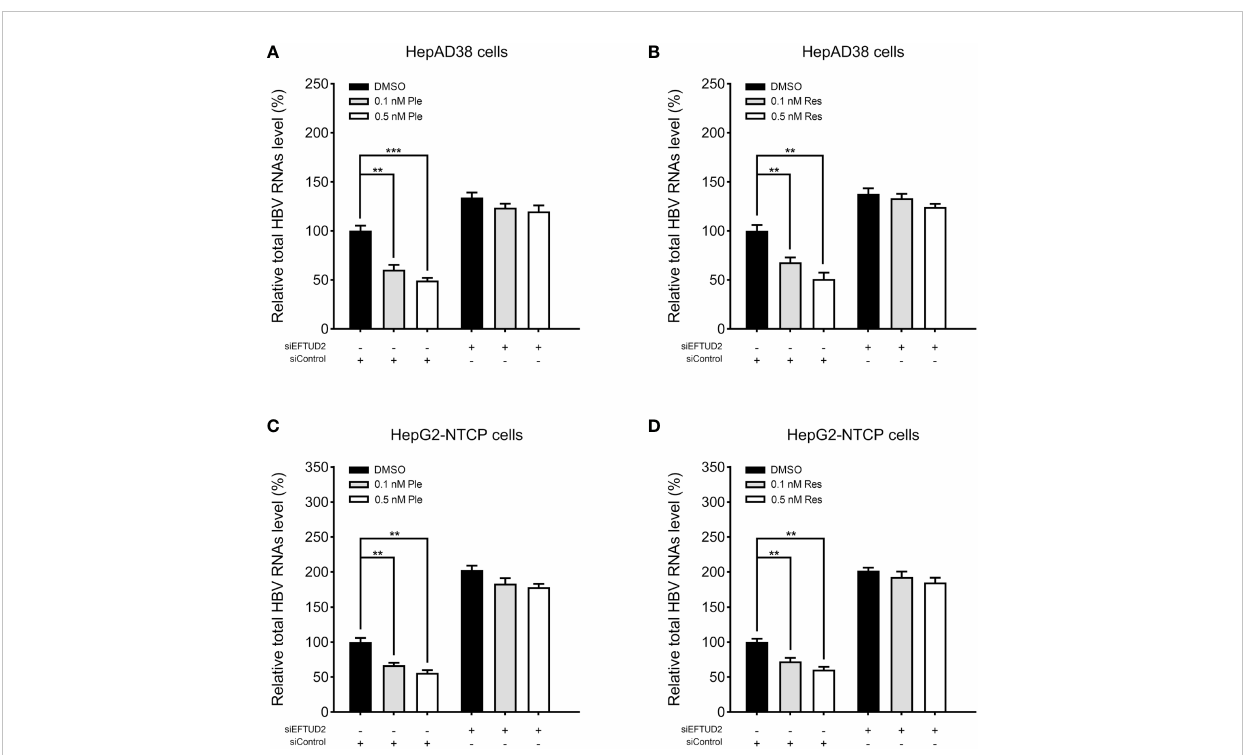
FIGURE 8 Plerixafor and resatorvid inhibited HBV by targeting EFTUD2. HepAD38 and HepG2-NTCP cells were transfected with siRNAs targeted EFTUD2 (siEFTUD2) or negative control (siControl) , and then, treated with DMSO, plerixafor or resatorvid at indicated concentrations for 7 days. The total HBV RNAs were extracted and quanti fi ed by qPCR. The results showed that knocking down EFTUD2 substantially impaired the anti-HBV effect of plerixafor and resatorvid, both in HepAD38 cells (A, B) and HepG2-NTCP cells (C, D) . **, P < 0.01; ***, P <